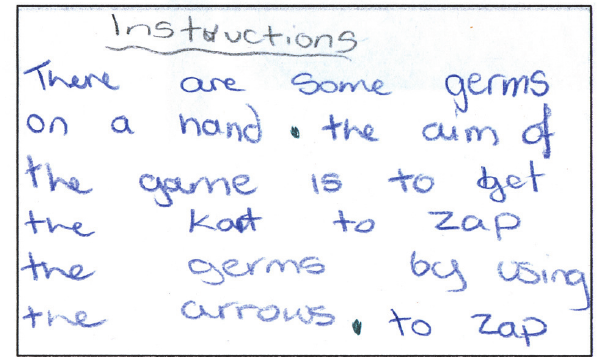
Figure 2. Child provides instructions on how to play As would be expected the quality of the drawings and level of detail provided varied between groups, Figure 3 shows an example of a drawing that is difficult to convert into a gaming context. It would appear that the user needs to click on the soap to put it on his or her hand but from a gaming perspective it is difficult to distil the challenge, or other attributes such as fun, from this design.